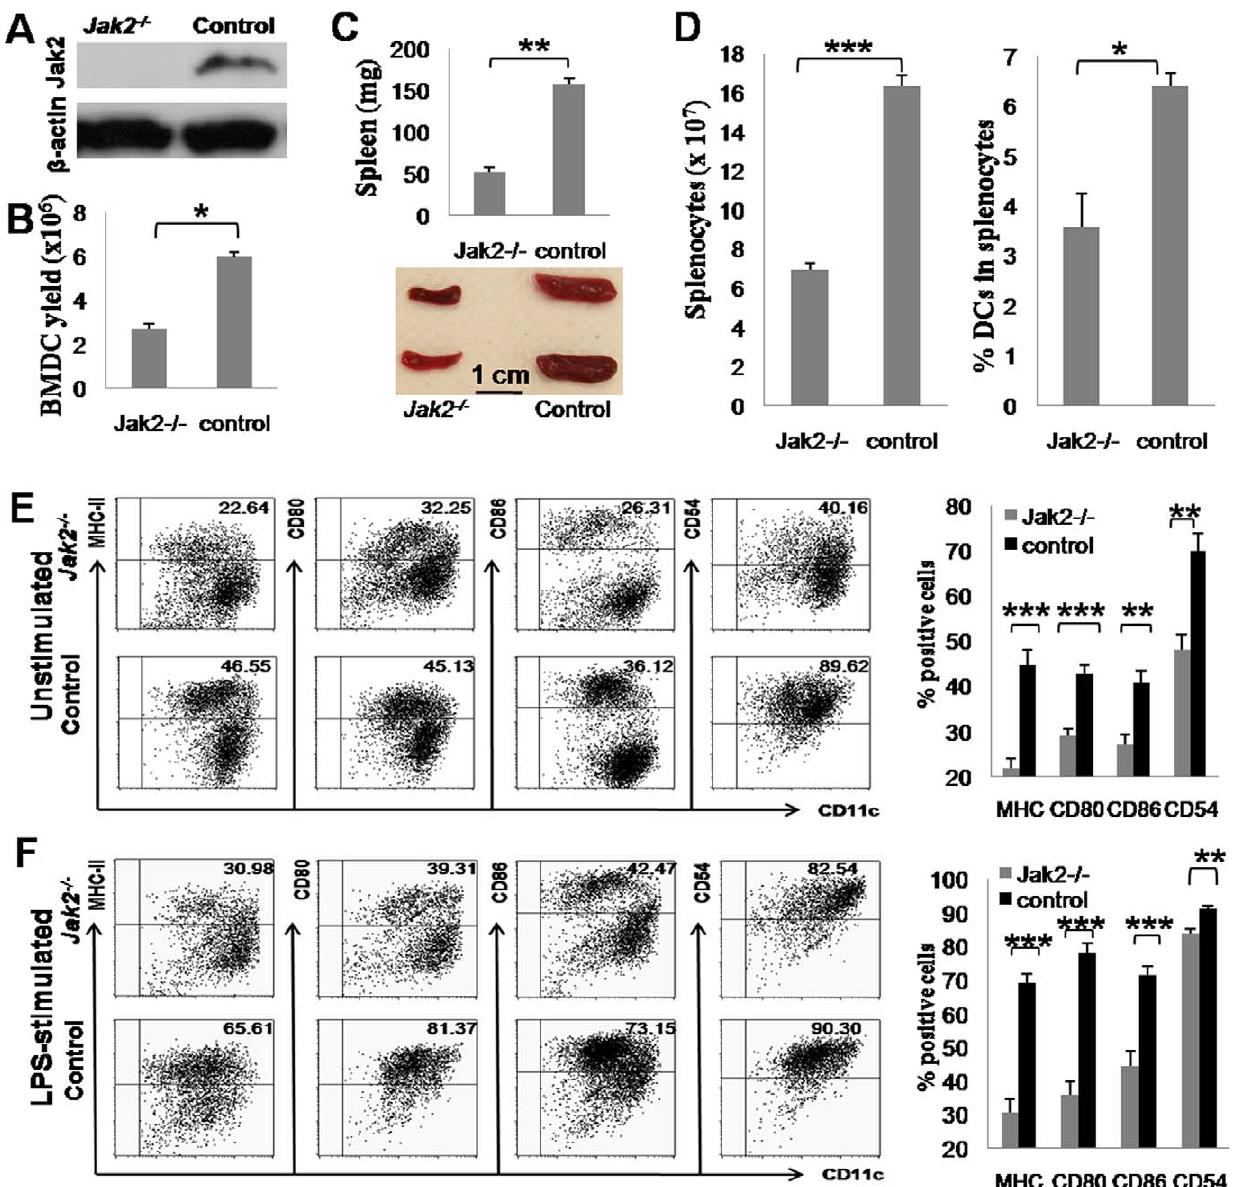
Figure 1. Jak2 is essential for DC development and maturation. (A) Tamoxifen efficiently induced Jak2 deficiency in DCs. BMDCs were generated from Cre + / + Jak2 fl/fl mice after 2 wk of tamoxifen or carrier solution induction and then subjected to Western blot analysis of Jak2 expression. High levels of Jak2 were detected in control mice, while Jak2 was absent in tamoxifen induced mice. (B) Loss of Jak2 significantly reduced BMDC yield. Bone marrow cells (1 6 10 7 ) were used to generate BMDCs using GM-CSF (10 ng/ml) and IL-4 (5 ng/ml) as described. Bone marrow cells deficient for Jak2 showed 1.3-fold decrease of BMDC yield. (C) Jak2 2 / 2 mice show significant smaller spleen size. Top panel: a bar graphic figure showing the average spleen weight of all mice analyzed; bottom panel: representative spleens from Jak2 2 / 2 and control mice. (D) Analysis of splenocytes in Jak2 2 / 2 and control mice. Both total splenocytes and the percentage of splenic DCs in total splenocytes were reduced in Jak2 2 / 2 mice as compared with that of controls. (E) BMDC surface marker expressions in the unstimulated condition. Left panel: a representative of flow cytometry data; right panel: a bar graphic figure showing the average percentage of BMDCs positive for each surface marker analyzed. (F) BMDC surface marker expressions after LPS stimulation. Similar as above, left panel is a representative of flow cytometry data, and right panel shows the average percentage of BMDCs positive for the corresponding surface marker. All data are present as mean 6 SE of four replicates. *, p , 0.05; **, p , 0.01; ***, p , 0.001. doi:10.1371/journal.pone.0009593.g001 Jak2 2 / 2 BMDCs showed similar potency as control BMDCs to splenic DCs (2000 rads) were then cocultured with BALB/c T cells stimulate alloreactive BALB/c T cell proliferation (Figure 3A, left as above, respectively. Consistently, splenic Jak2 2 / 2 DCs were potent to stimulate alloreactive T cell activation (Figure 3A, right panel). To confirm this observation, we performed similar studies panel). We next examined the capacity of Jak2 2 / 2 DCs to initiate using splenic DCs. Splenocytes pooled from 5 Jak2 2 / 2 or control mice were used to enrich splenic DCs as described. Irradiated antigen-specific T cell activation. For this purpose, irradiated